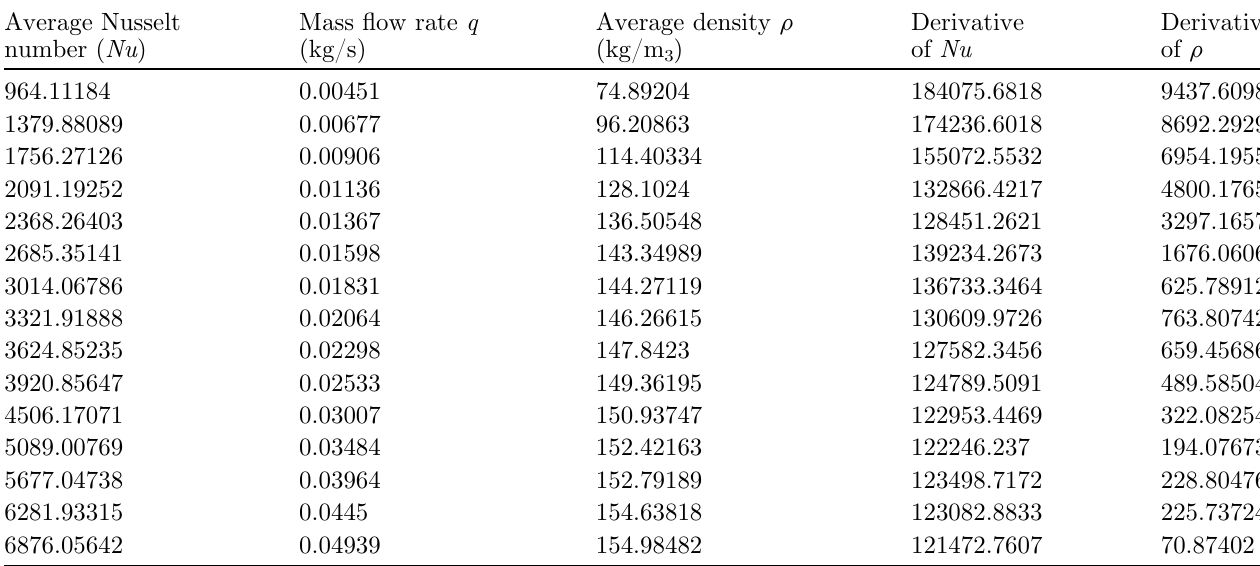
Table A2. Raw data used in Figure